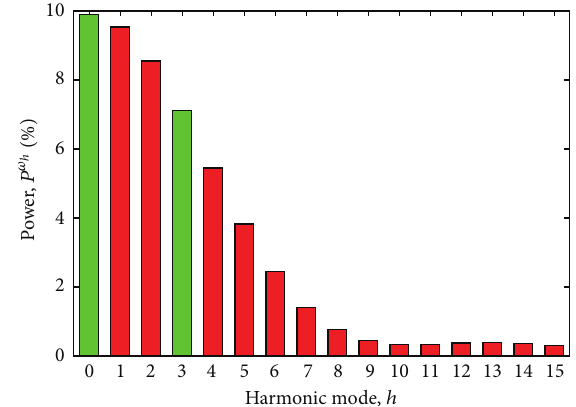
Figure 5: Single-pulse waveform, 𝑄 = 1 —multibeam sum pattern synthesis at 𝜔 0 and 𝜔 3 ( 𝑁 = 16 ; 𝑑 = 𝜆/2 ; 𝜃 𝜔 0 = 90 ∘ ; 𝜃 𝜔 3 = 120 ∘ )—plot of the power associated with the harmonic radiations in percentage on the total